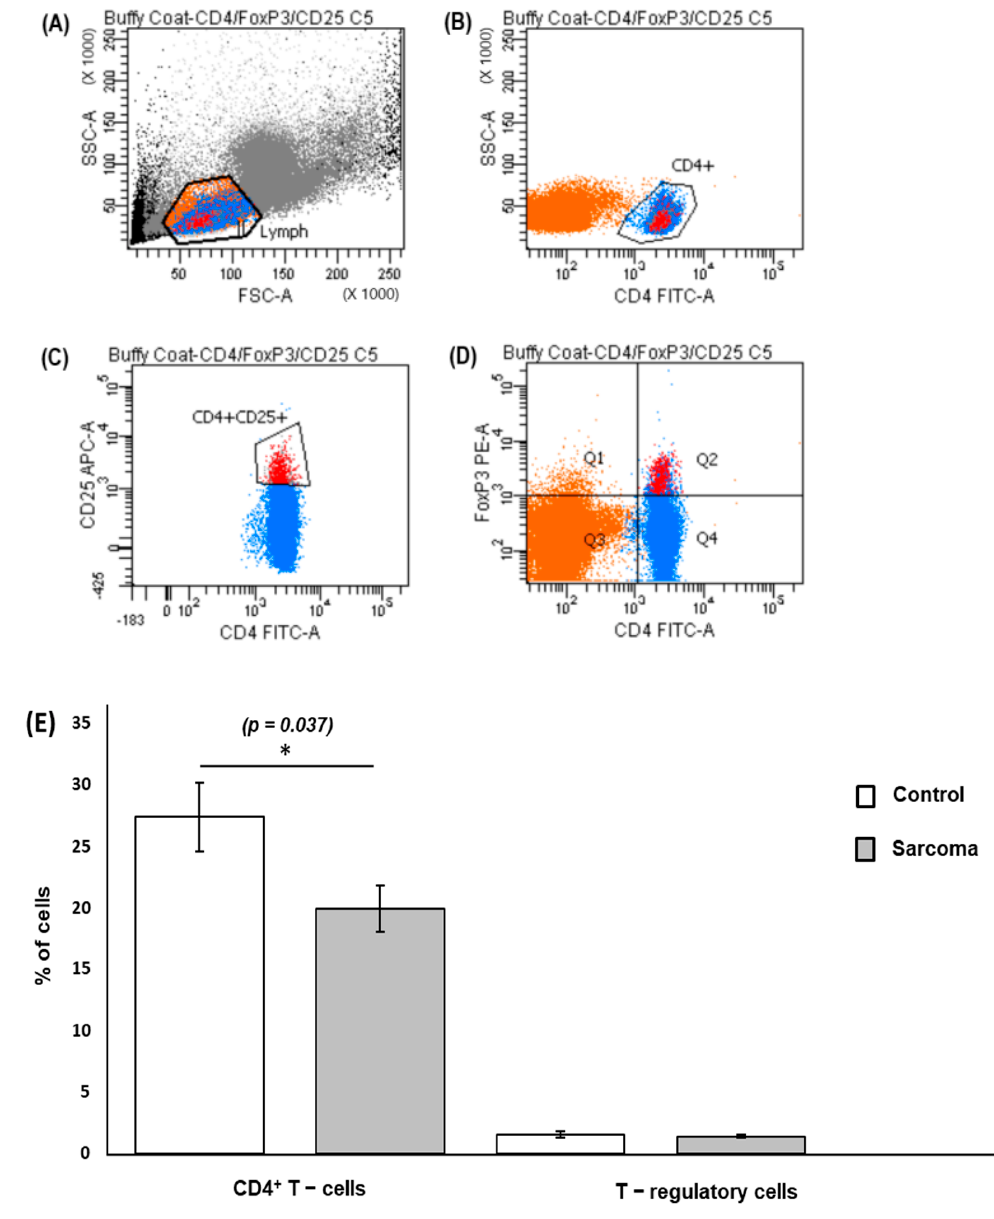
Figure 2. Gating strategy and flow cytometry quantification of CD4 + T cells and T-regulatory cells. PBMCs were extracellularly stained with FITC-conjugated anti-human CD4 antibody and APC-conjugated anti-human CD25 antibody and intracellularly stained with PE-conjugated anti-human FOXP3 antibody. ( A ) Lymphocyte population (labelled in orange) was gated from PBMCs following forward scatter (FSC) and side scatter (SSC) characteristics. ( B ) Gated lymphocytes were then separated into CD4 + T cells (labelled in blue). ( C ) CD4 + CD25 + cells. ( D ) CD4 + CD25 + FoxP3 + cells (labelled in red, Q2). A minimum of 25,000 CD4 + T cells was gated for each sample during analysis. ( E ) Mean percentage of CD4 + T cells and Treg cells in sarcoma patients and normal controls. * Results show a significantly lower percentage ( p = 0.037) of the CD4 + T cells in lymphocytes in sarcoma patients (20.18 ± 1.91%) compared to normal controls (27.76 ± 2.82%). The percentage of Treg cells in CD4 + T cells in sarcoma patients showed no significant difference (1.40 ± 0.12%) when compared to normal controls (1.53 ± 0.22%). For CD4 + T cells and Treg cells, data are represented as mean percentage of CD4 + T cells/T-lymphocytes ± standard error (SE) and Treg cells/CD4 + T cells ± standard error (SE), respectively.